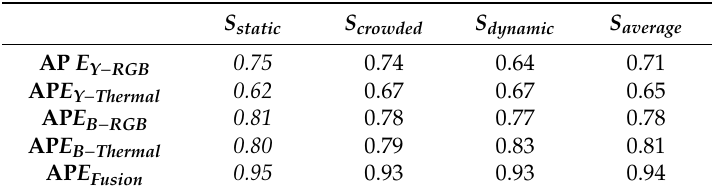
Table 5. Comparison of the average